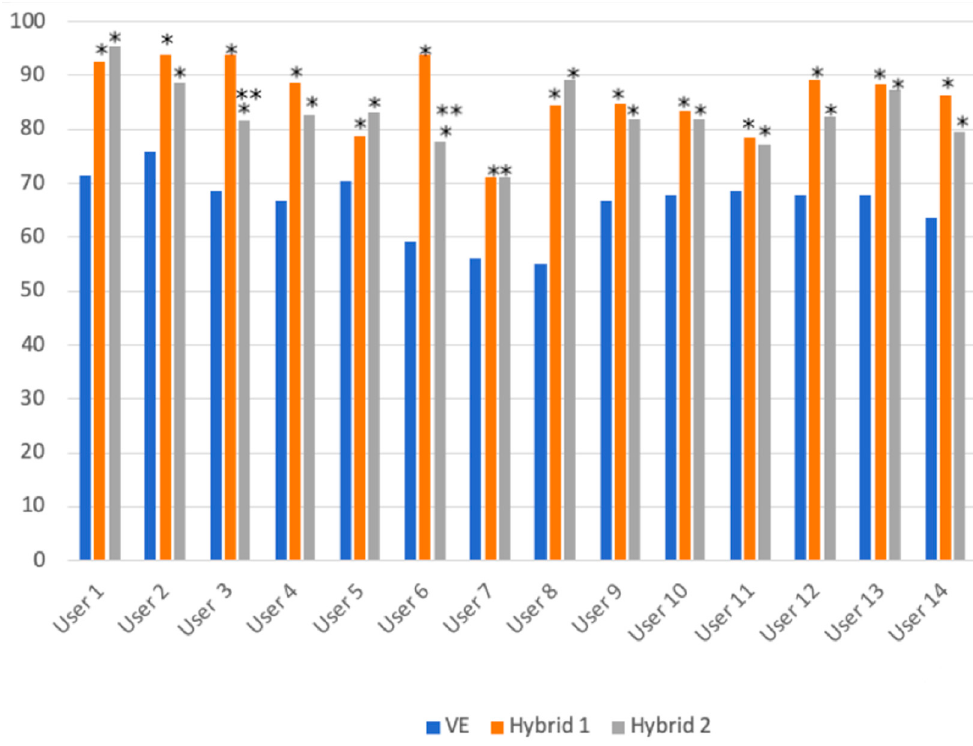
Figure 1. The accuracy to predict an ischemic fractional flow reserve based on each operator’s visual estimation, Hybrid 1 or Hybrid 2 approaches. * above each column depicts a p -value < 0.05 between VE and Hybrid approach; ** a p < 0.005 between the Hybrid 1 and Hybrid 2 approach.